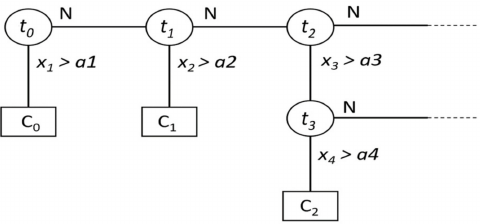
Figure 4. Fast decision tree nodes and their decision